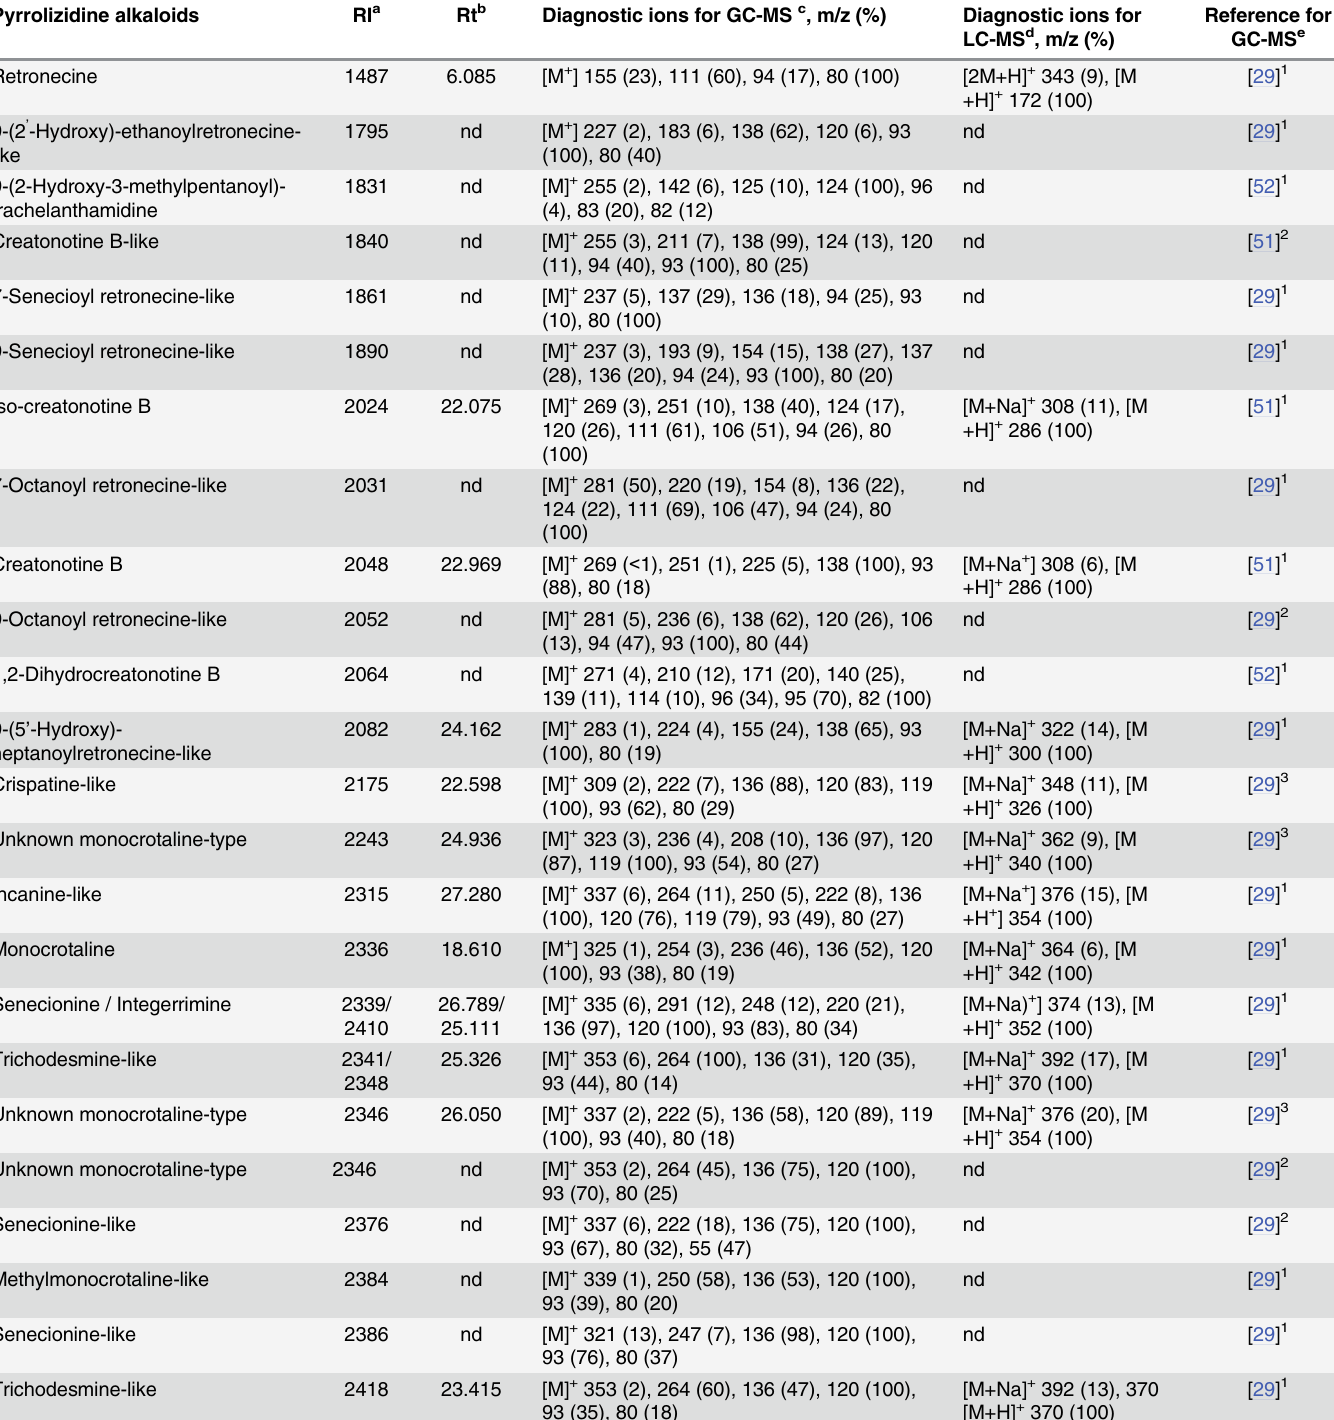
Table 2. Mass fragmentation pattern of pyrrolizidine alkaloids found in Crotalaria species and in adults of Utetheisa ornatrix fed on these host plants. The analyses were carried out by gas chromatography-mass spectrometry (GC-MS) in electron impact mode and liquid chromatography-mass spec- trometry (LC-MS) in electrospray ionization